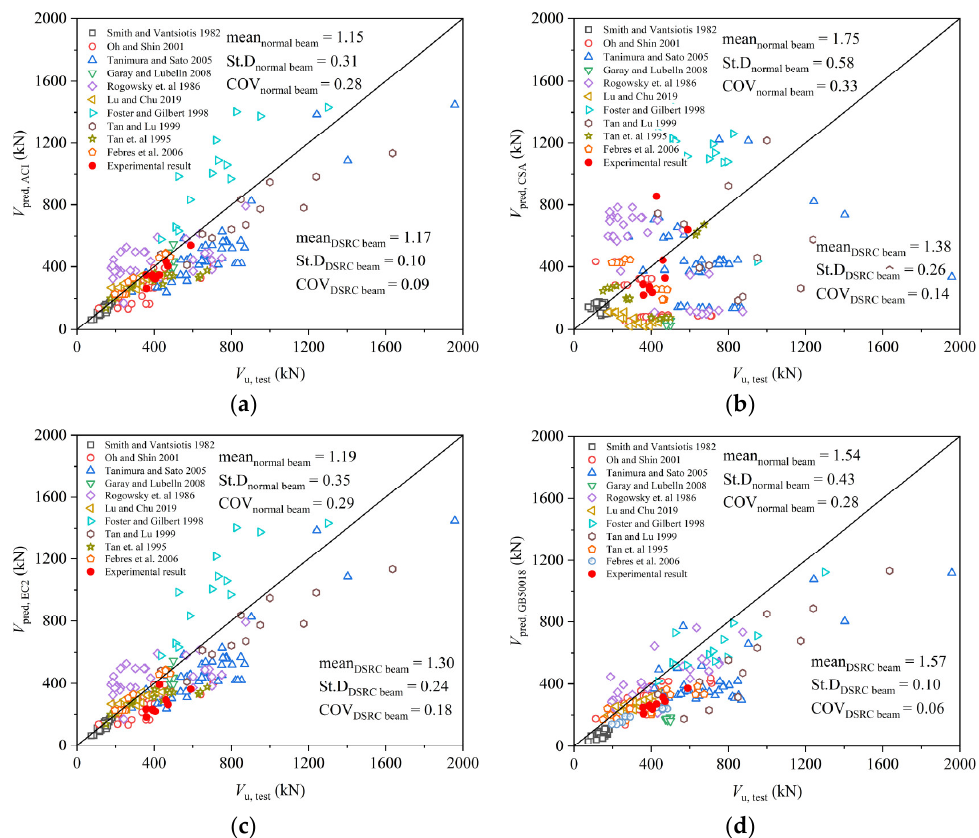
Figure 9. Comparison of experimental results of this paper and the included studies [46,48–55,59] with the predictions of ( a ) ACI318–11; ( b ) GB50010–2010; ( c ) EN 1992–1–1; ( d ) CSA A23.3–04.